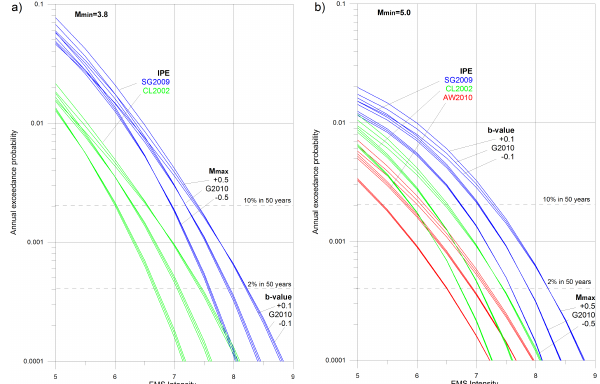
Figure 10. Hazard curves calculated for different combinations of the input parameters: (a) for M min = 3 . 8 and IPE from Stromeyer and Grünthal (2009) and Chandler and Lam (2002), (b) for M min = 5 . 0 and all three considered